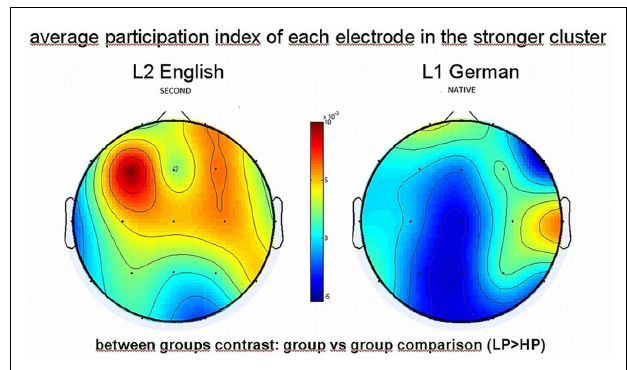
FIGURE 6 |Topography distribution brain maps of the average participation of each electrode (synchronization cluster index) in the strongly synchronized cluster within the gamma band detected by PLI. Comparison shown here: LP > HP group (group contrast, HP subtracted from LP group). Color bar (red color) indicating the greatest increment of involvement of the electrodes in left frontal/fronto-central areas during L2 (left panel) processing in the LP